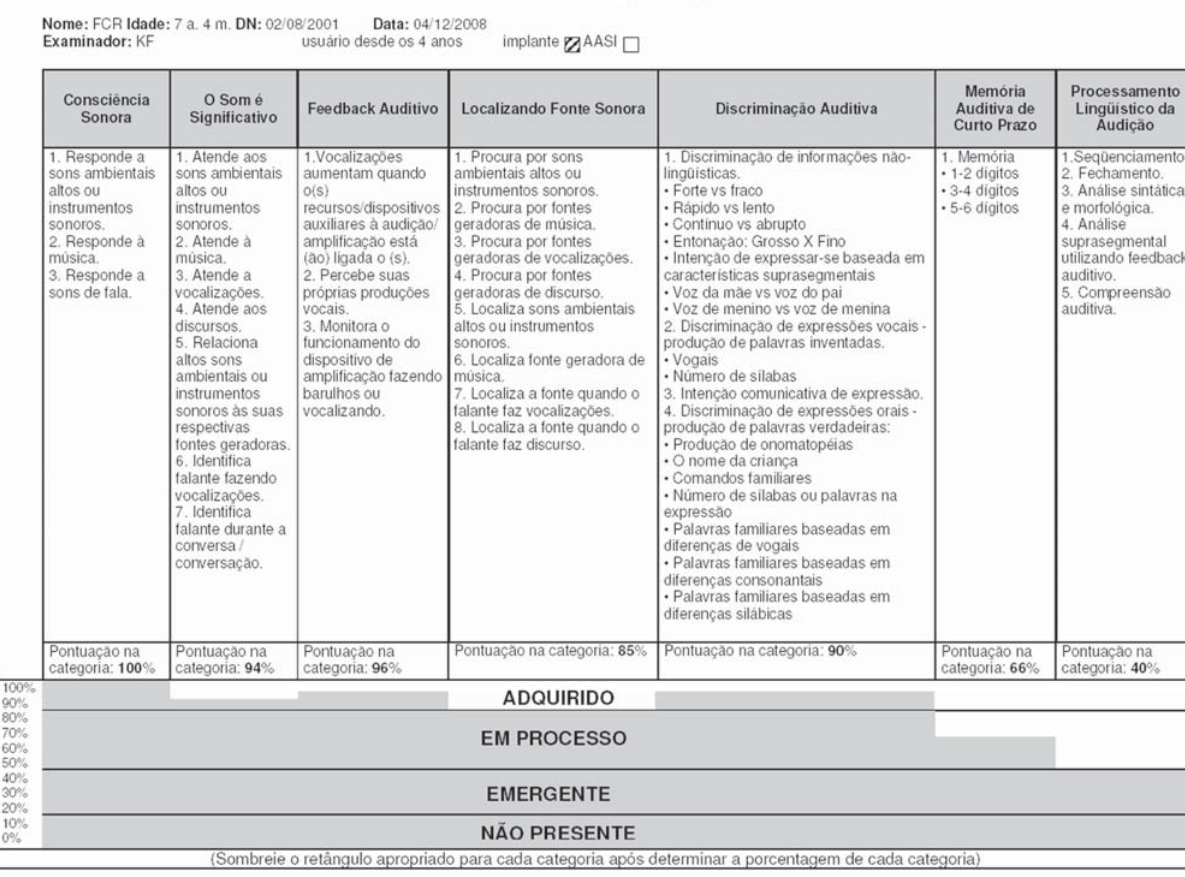
Figure 2- Evaluation results using the Brazilian FAPI (original in English: Stredler-Brown & Johnson 25